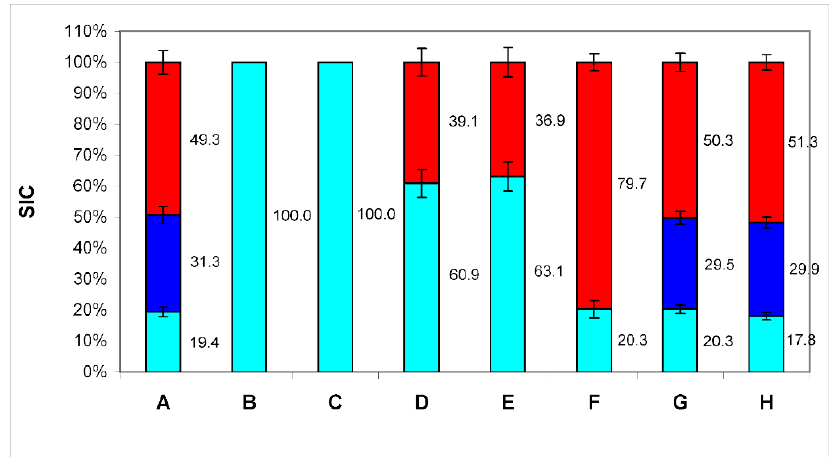
Figure 1. The ratio of the contributions to scattering (SIC) of three particle fractions (BSA—cyan color, exomeres—blue color, and exosomes—red color) in conditioned medium samples after treatment with antibodies bound to protein A immobilized on microspheres. A—SIC of conditioned medium samples; B—SIC of conditioned medium samples after treatment with antibodies bound to protein A immobilized on microspheres to markers CD9; C—SIC of conditioned medium samples, after treatment with antibodies bound to protein A immobilized on microspheres to markers CD63; D—SIC of conditioned medium samples, after treatment with antibodies bound to protein A immobilized on microspheres to markers CD81 in the final concentration of 1 µ L of antibodies per 1 mL of medium; E—SIC of conditioned medium samples, after treatment with antibodies bound to protein A immobilized on microspheres to markers CD81 in the final concentration of 2 µ L of antibodies per 1 mL of medium; F—SIC of conditioned medium samples, after treatment with antibodies bound to protein A immobilized on microspheres to markers HSP90; G—Negative control 1: SIC of conditioned medium samples, after treatment with antibodies to the CD3 marker; H—Negative control 2: SIC of conditioned medium samples, after treatment protein A without antibodies. The numbers on the graph—SIC of this fraction in